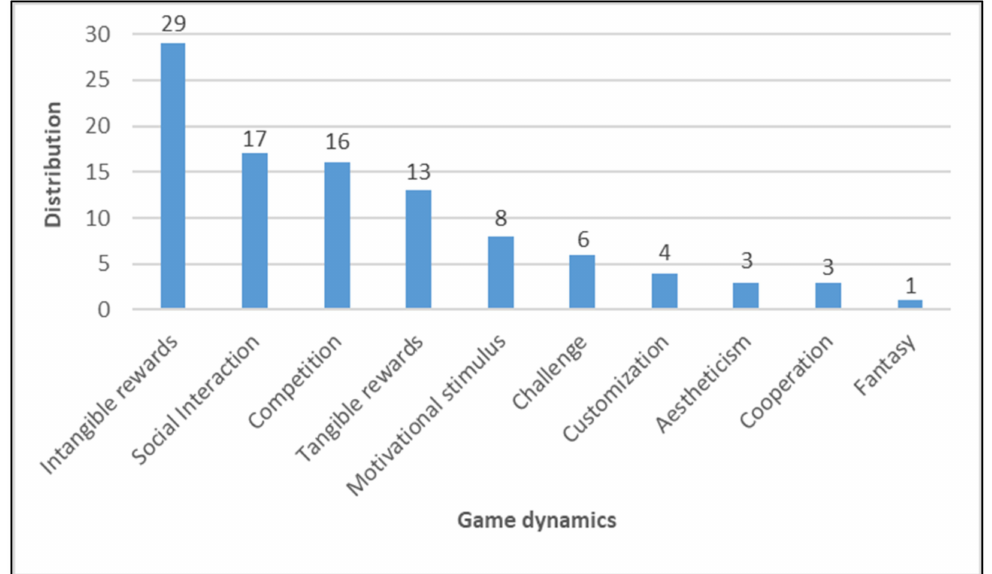
Figure 2. Distribution of game dynamics across the surveyed case